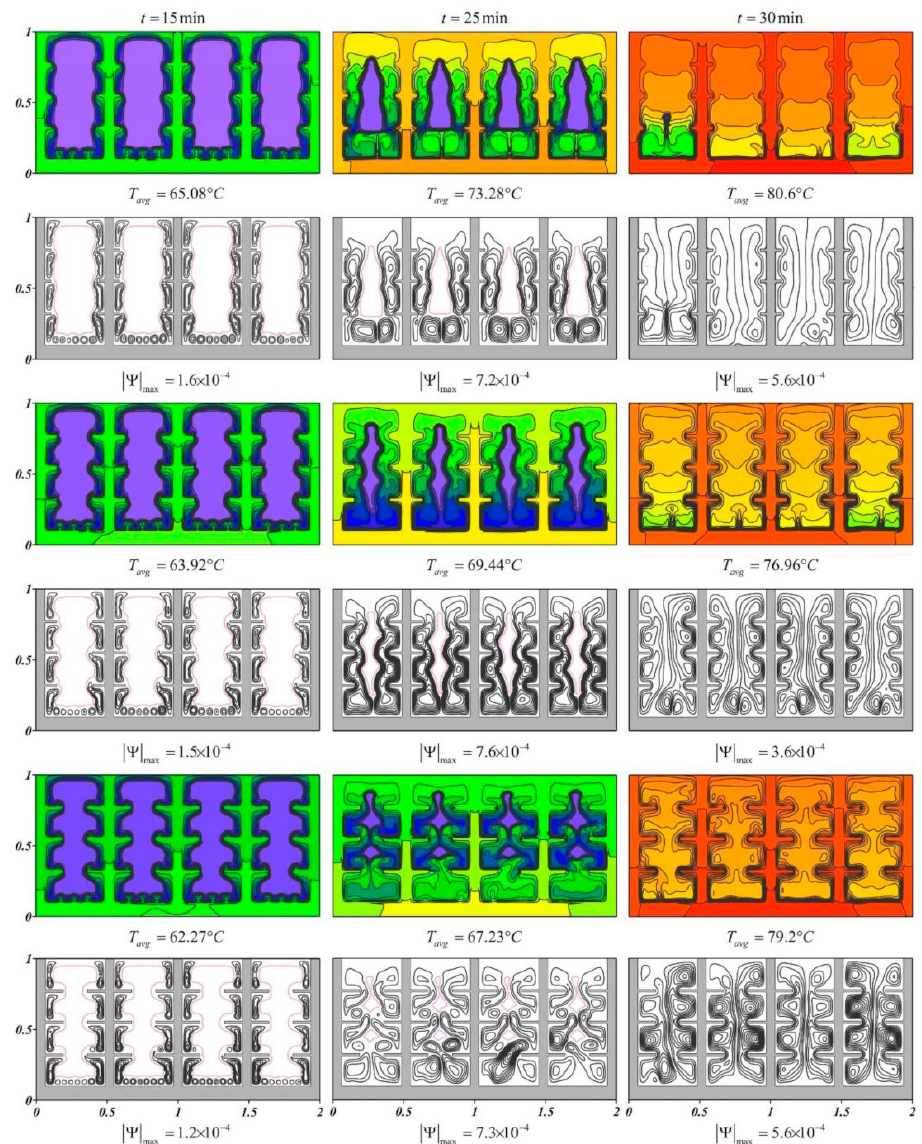
Figure 6. Temperature fields and streamlines at Os = 0.338 for the cases of l = H /24, l = H /12, and l = H /8 at the time moments t = 15, t = 25, and t = 30